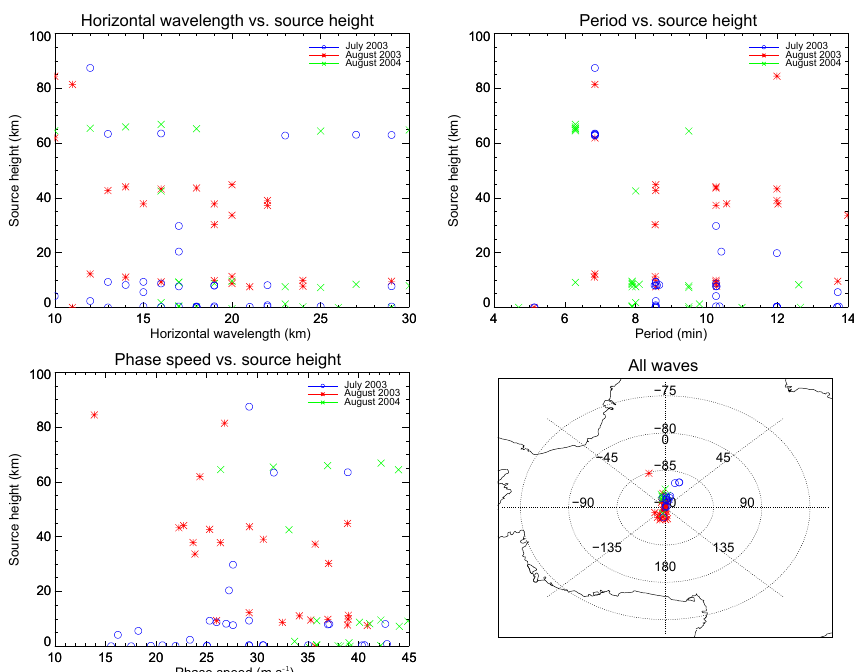
Figure 6. Plots comparing horizontal wavelength (top left), period (top right), and phase speed (bottom left) of the observed waves to the height of their sources as determined by individual GROGRAT runs for the 87 wave events found to be freely propagating waves. The waves are differentiated by month and year, with blue circles representing waves observed during June 2003, red “x” marks denoting waves observed during August 2003, and green “x” marks showing waves observed during August 2004. The bottom right panel shows a plot of the latitude and longitude of the wave sources near the South Pole, from which it is apparent that all but six waves originate within 2.5 ◦ of SPA.